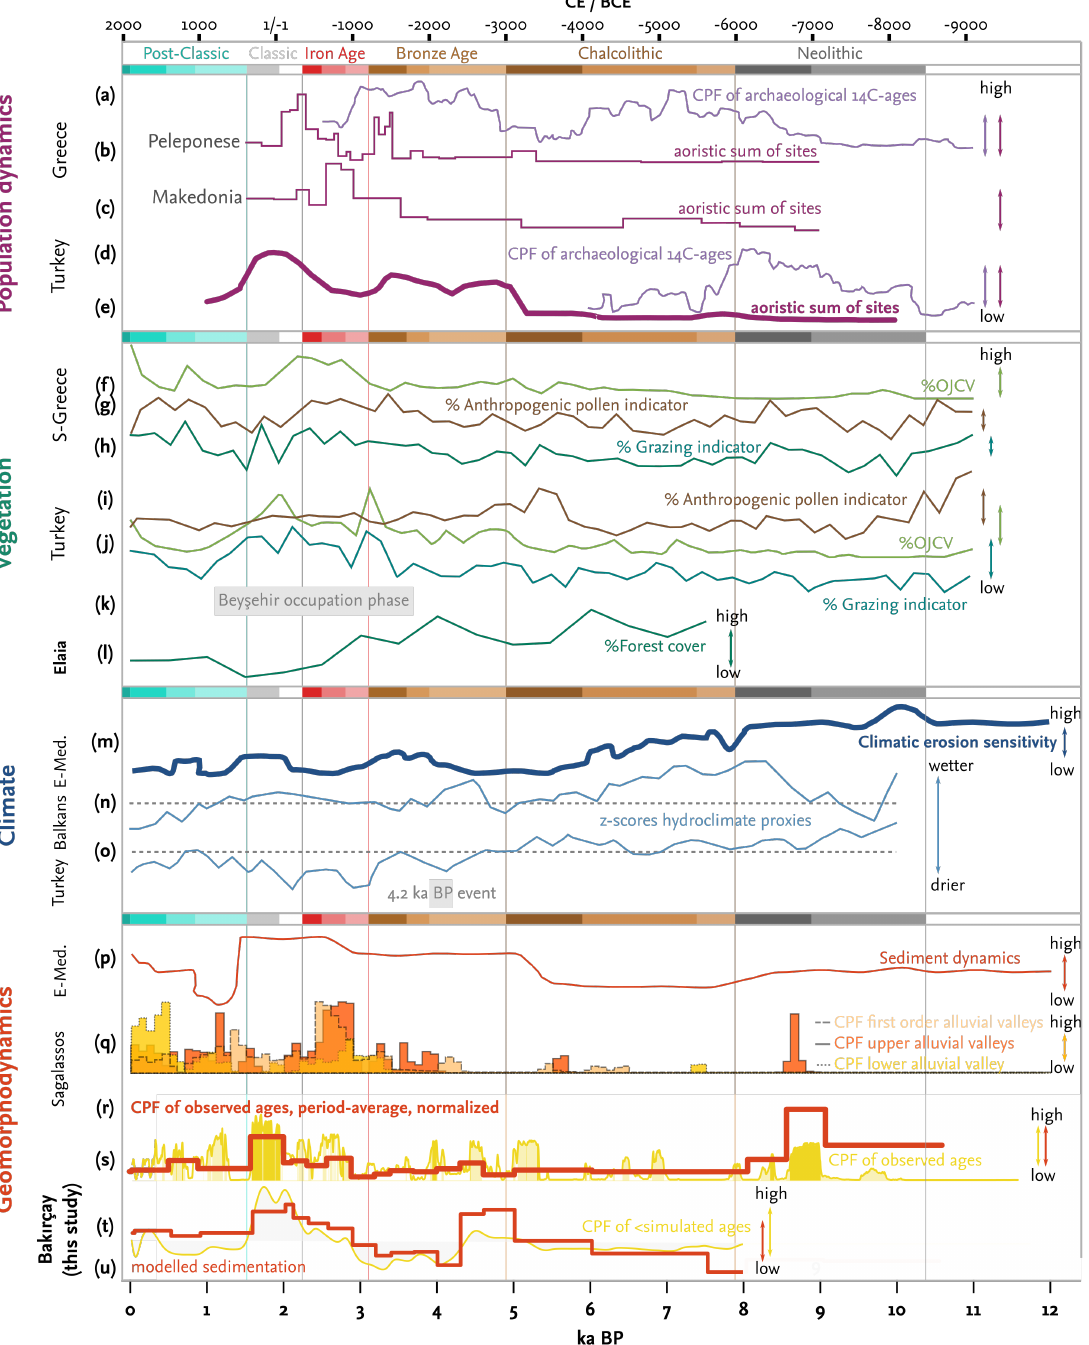
Figure 5. Comparison of the indicators for changing geomorphodynamics from this study in comparison with other archaeological/environmental proxies. Only relative values are shown. References: a: [104]; b, c: [105]; d: [104]; e: [106]; f, g, h: [105]; i, j: [106]; k: [107]; l: [41], interpolated; m: [7]; n, o: [99]; p: [7]; q: [8]; r–u: this